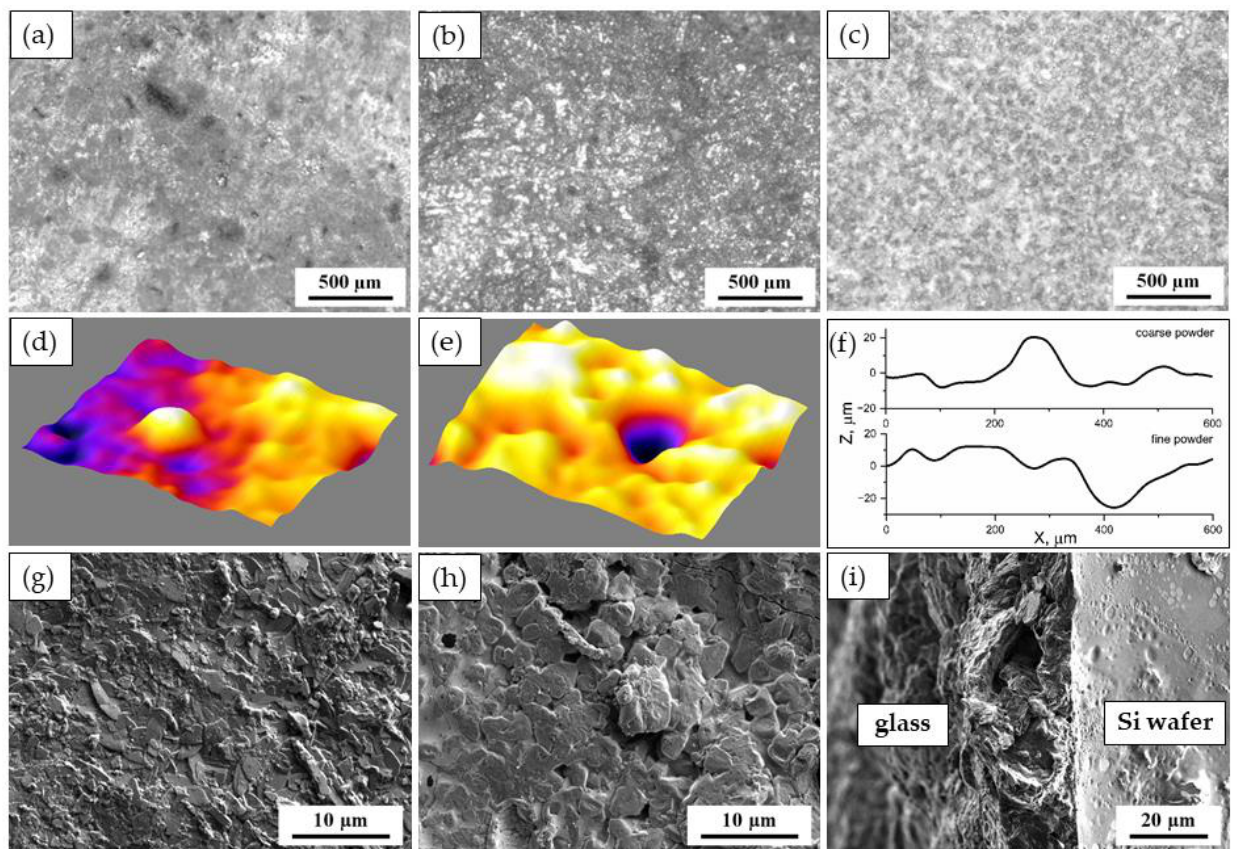
Figure 4. Morphology of fired PbO·ZnO·P 2 O 5 glass layers. LM micrographs for the layers from ( a ) pure coarse powder, ( b ) with 2 wt. % graphite, ( c ) fine powder; the surface roughness maps for the layer from ( d ) coarse powder with 2 wt. % graphite, ( e ) fine powder layer and their z-profiles ( f ); SEM micrographs for the layer from ( g ) coarse powder, ( h ) fine powder layer top, and cross-section ( i ).